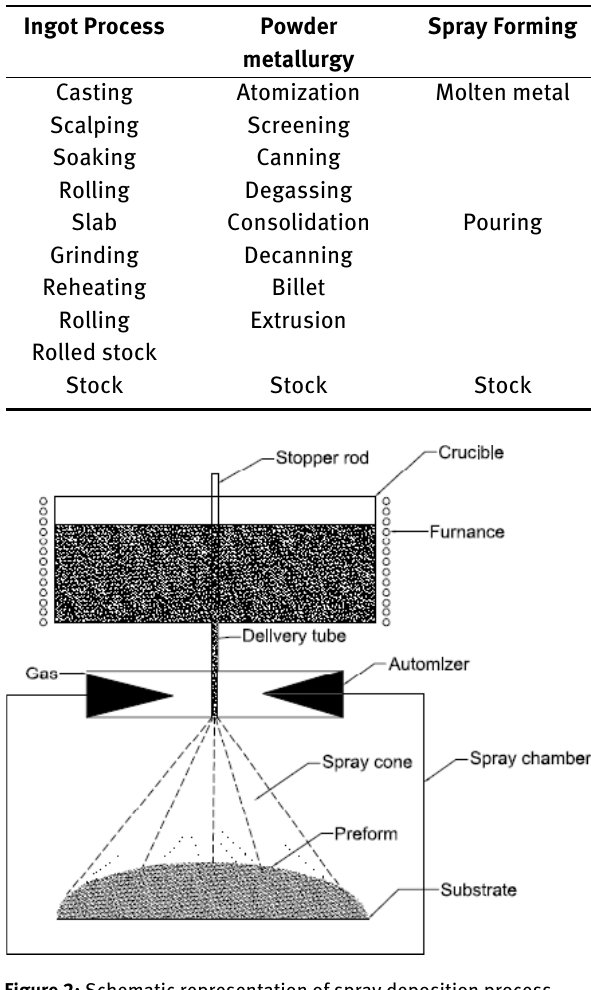
Figure 2: Schematic representation of spray deposition